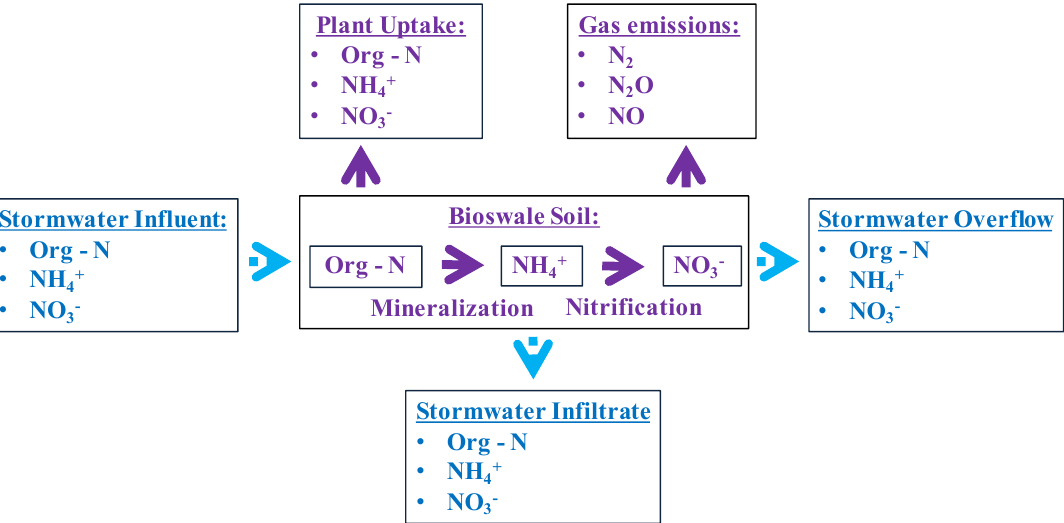
Figure 1. Simplified nitrogen cycle within bioswales: Solid purple arrows denote nitrogen fluxes quantified in this study, while blue dotted arrows denote well-documented liquid-phase fluxes that occur during wet weather only.